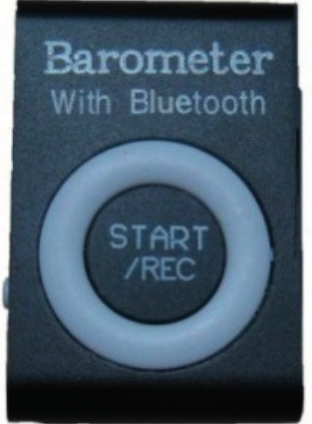
Figure 4. WTZ809A is a portal barometer with Bluetooth. It can work with Android smartphones or PCs though Bluetooth conjunction and can automatically measure, record, and send barometric pressure and temperature at a certain